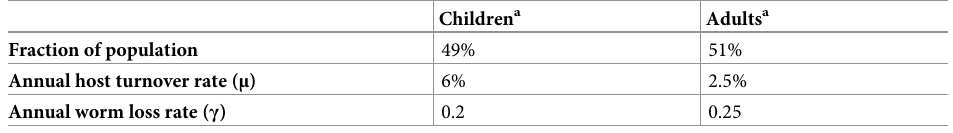
Table 2. Demographic inputs for the two age strata of the modeled